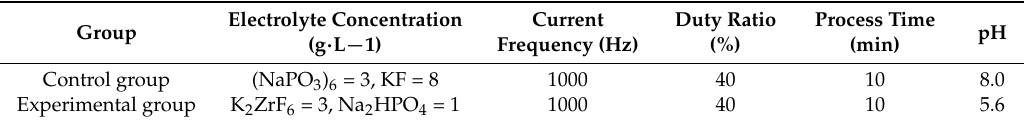
Table 1. Electrolyte concentration and experimental parameters during the plasma electrolytic oxidation (PEO)